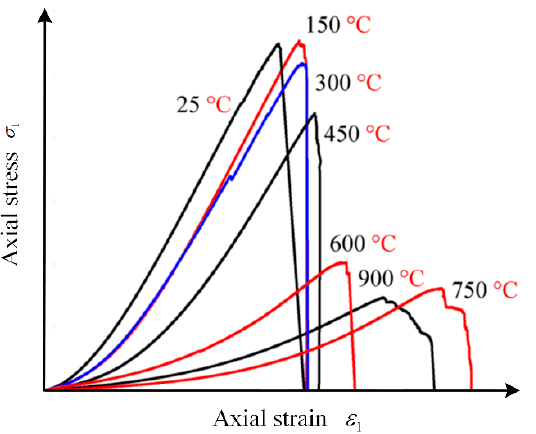
Figure 2. Stress-strain curves of Granite during uniaxial compression under various temperatures [24].